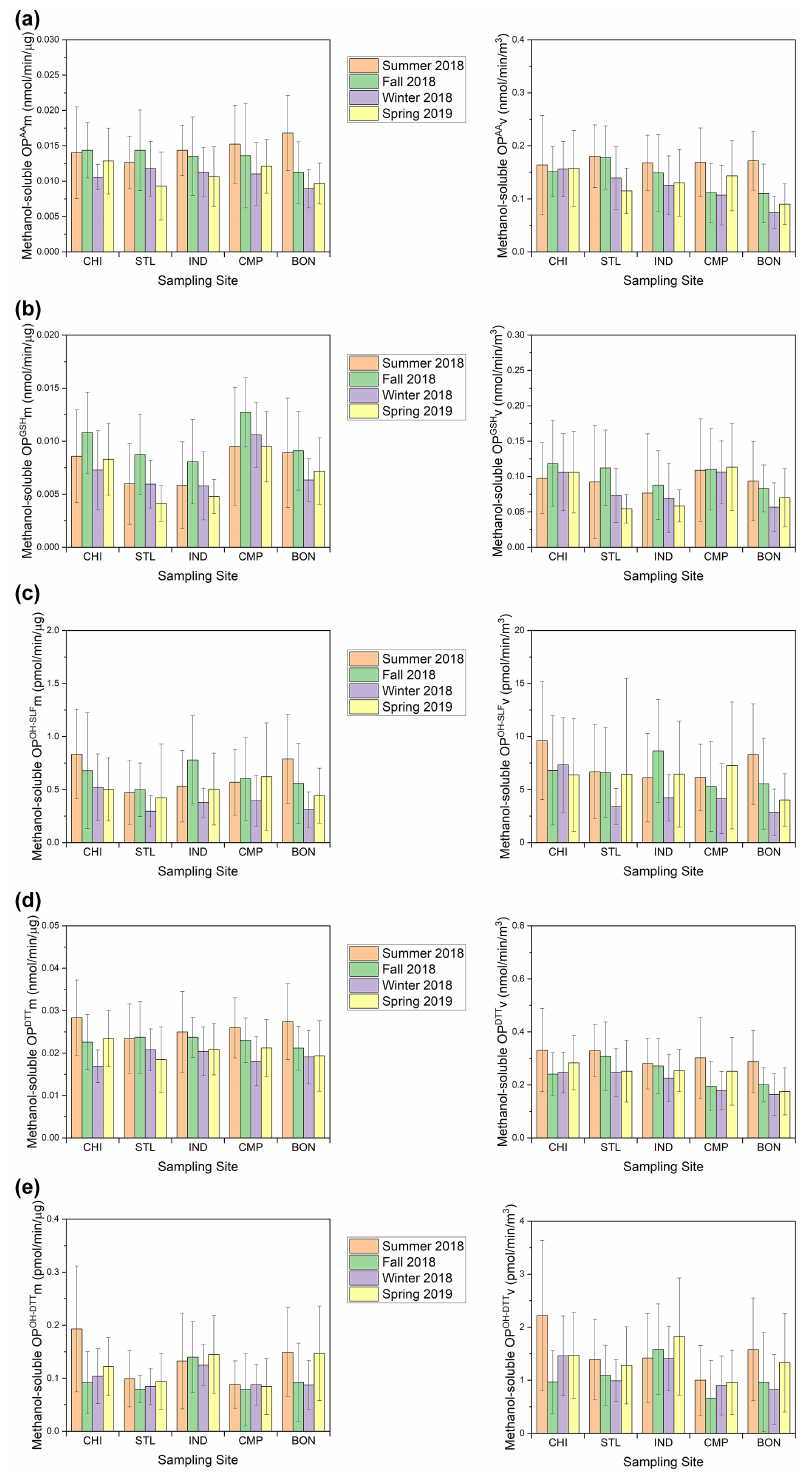
Figure 6. Seasonal averages of mass-normalized (left) and volume-normalized (right) methanol-soluble OP activities for (a) OP AA , (b) OP GSH , (c) OP OH − SLF , (d) OP DTT , and (e) OP OH − DTT at our sampling sites.